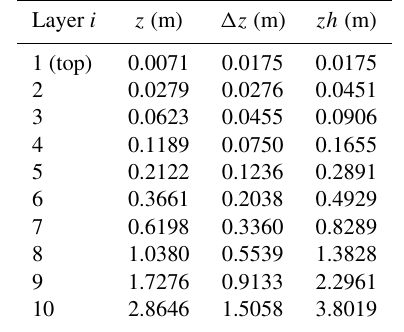
Table 2. Nodal depth, z , thickness, (cid:49)z , and depth at the layer inter- face, zh , of the 10 soil layers used by